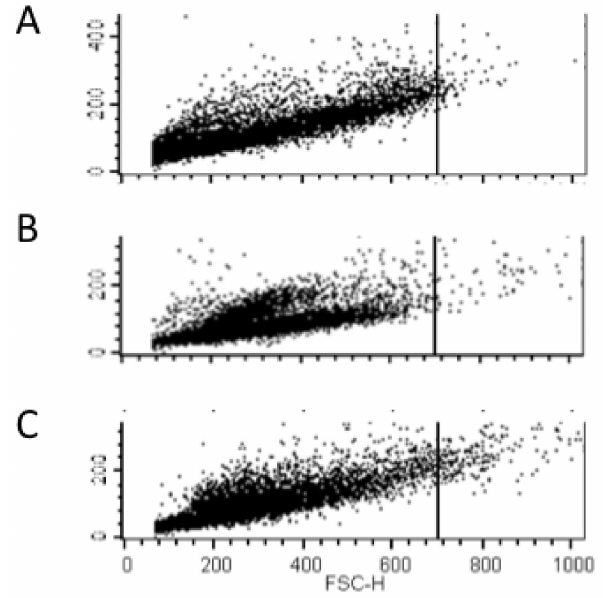
Figure 6. Flow cytometry analysis of C.albicans flight samples and ground controls. Panel A represents a dot plot of C. albicans yeast cells grown at 30 u C (to set the threshold for non-flocculated organisms). Panels B and C illustrate dot plots of ground and flight samples respectively. The Y-axis represents side-scatter and the X-axis forward scatter (FSC). Events with FSC values below the established threshold were considered single or budding yeast, whereas events above the established threshold were considered cell